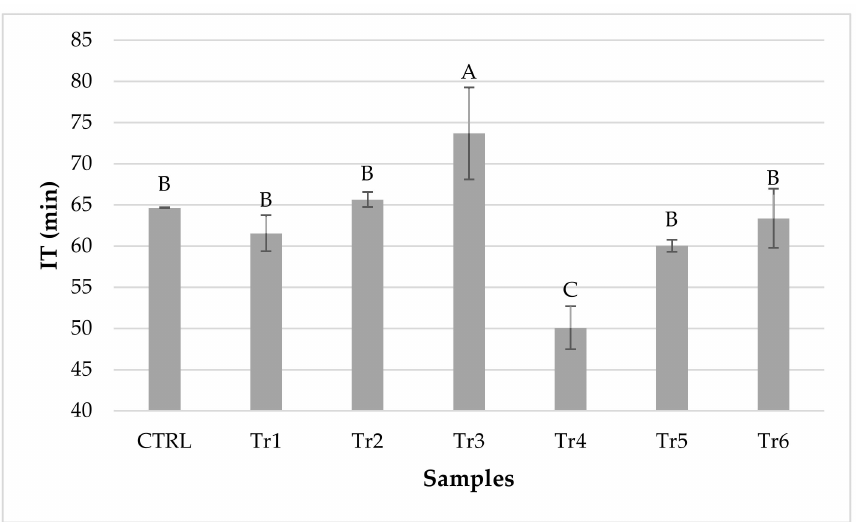
Figure 2. Results of the RapidOxy Test of the ripened sausages. CTRL, control; Tr, trial; IT, Induction Time. CTRL (0 mg/kg OLE; 300 mg/kg NO), Tr1 (200 mg/kg OLE; 150 mg/kg NO), Tr2 (400 mg/kg OLE; 150 mg/kg NO), Tr3 (800 mg/kg OLE; 150 mg/kg NO), Tr4 (200 mg/kg OLE; 0 mg/kg NO), Tr5 (400 mg/kg OLE; 0 mg/kg NO), Tr6 (800 mg/kg OLE; 0 mg/kg NO). Different letters indicate significant differences at p <